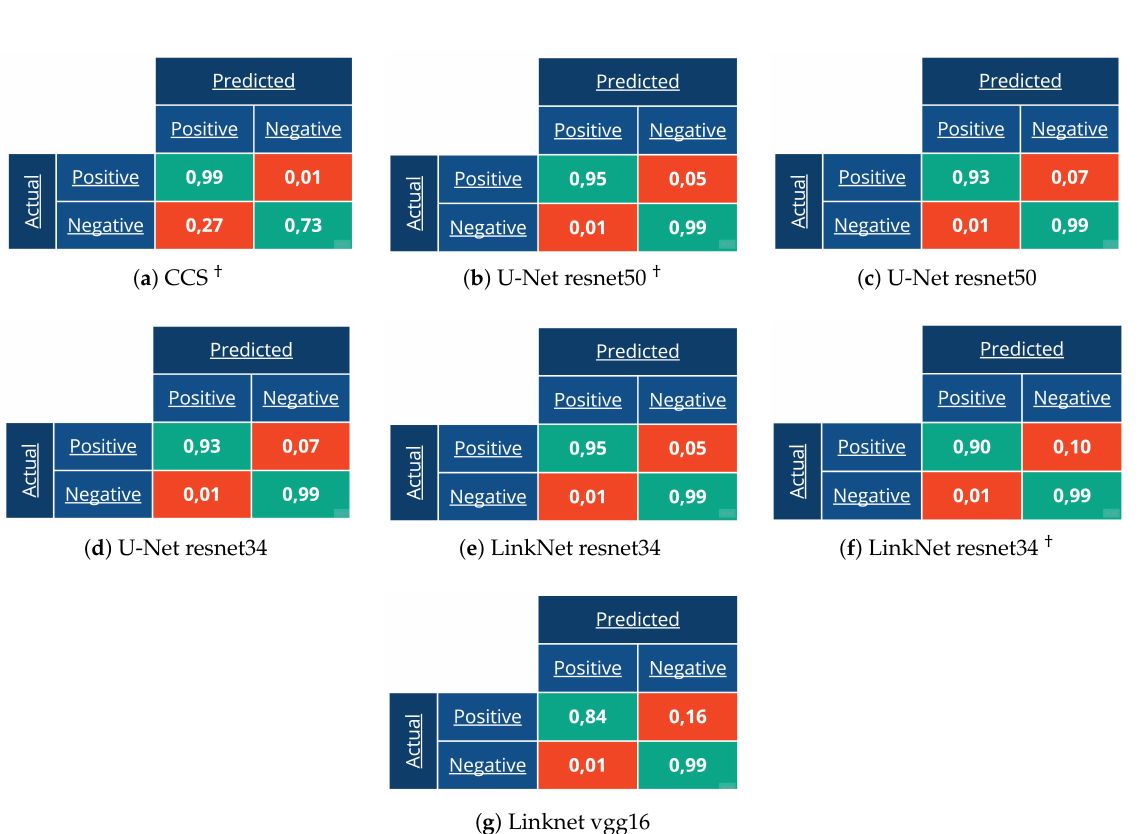
Figure 6. Confusion matrix from the prediction to ( a – d ) U-Net model, where ( a ) is CCS model, ( e – g ) LinkNet model. The weights of a pre-trained network with ImageNet are used to initialize each of the models (For the models † , weights were randomly